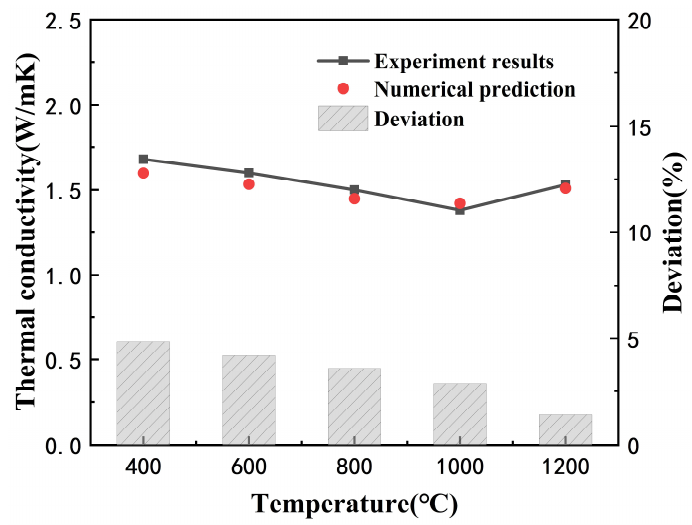
Figure 5. Comparison of numerical results and experimental results.